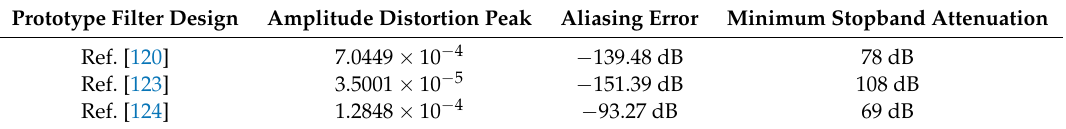
Table 1. Analysis of prototype filter design in [120,123,124] by amplitude distortion peak, aliasing error, minimum stopband attenuation.